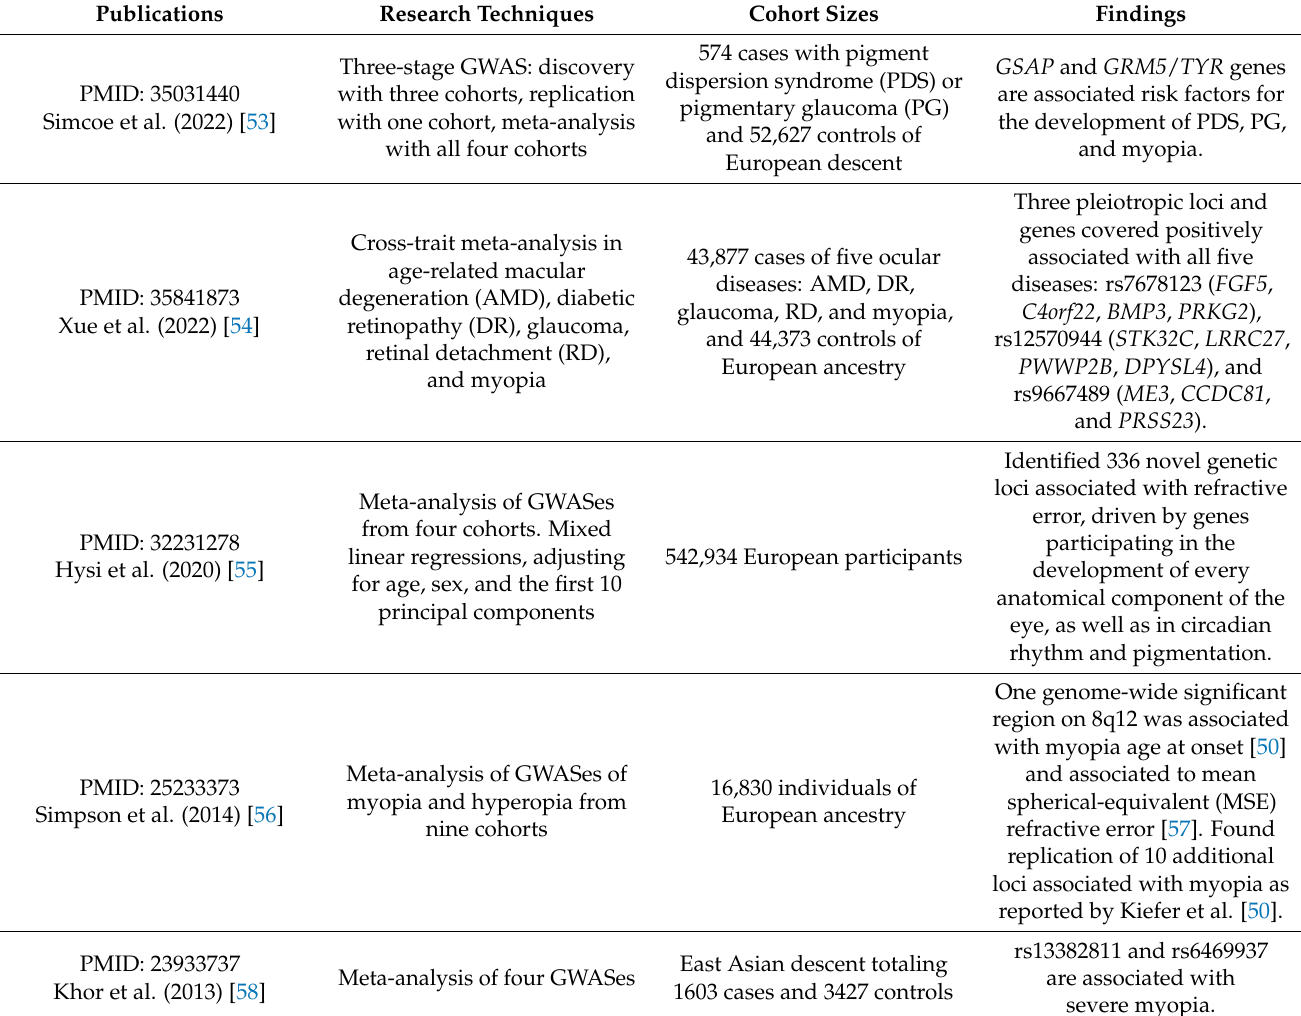
Table 1. GWAS in humans indicated that refractive error is influenced by both common and rare variants with a significant environmental